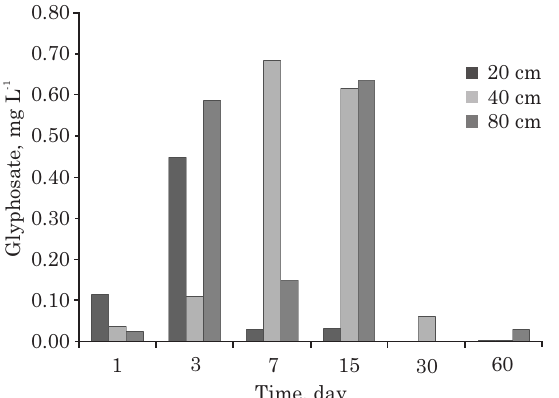
Figure 4. Glyphosate concentrations at different soil depths during the sampling